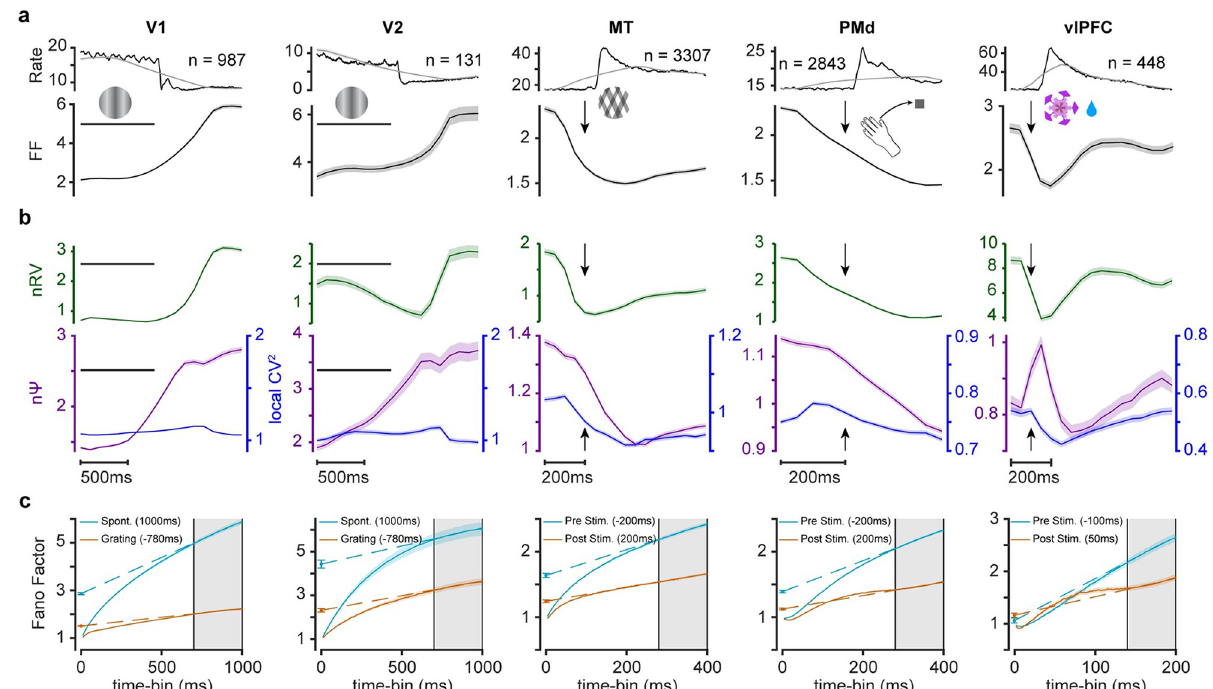
Fig 5. Concurrent changes in rate variability and spiking irregularity during stimulus presentation or movement execution across the cerebral cortex. (a) Average population PSTH across 5 different cortical regions responding to the stimulus presentation (areas V1, V2, MT, vlPFC) or movement execution (PMd). Black and gray traces show PSTHs with bin-widths equal to 10ms and matching time-bins used for estimation of FF and variability components in each region, respectively (time-bin = 1000, 1000, 400, 400, 200ms sliding by 100ms for V1/2 and 50ms for the rest respectively) (top) and FF dynamics for each region (bottom). Horizontal line indicates stimulus on period and arrow indicates stimulus onsets. (b) Concurrent temporal changes in nRV (top) and in n C (bottom) across cortical regions. Temporal dynamics of CV 2 format as Fig 3f for each cortical area pre- and post- sensory or movement event.